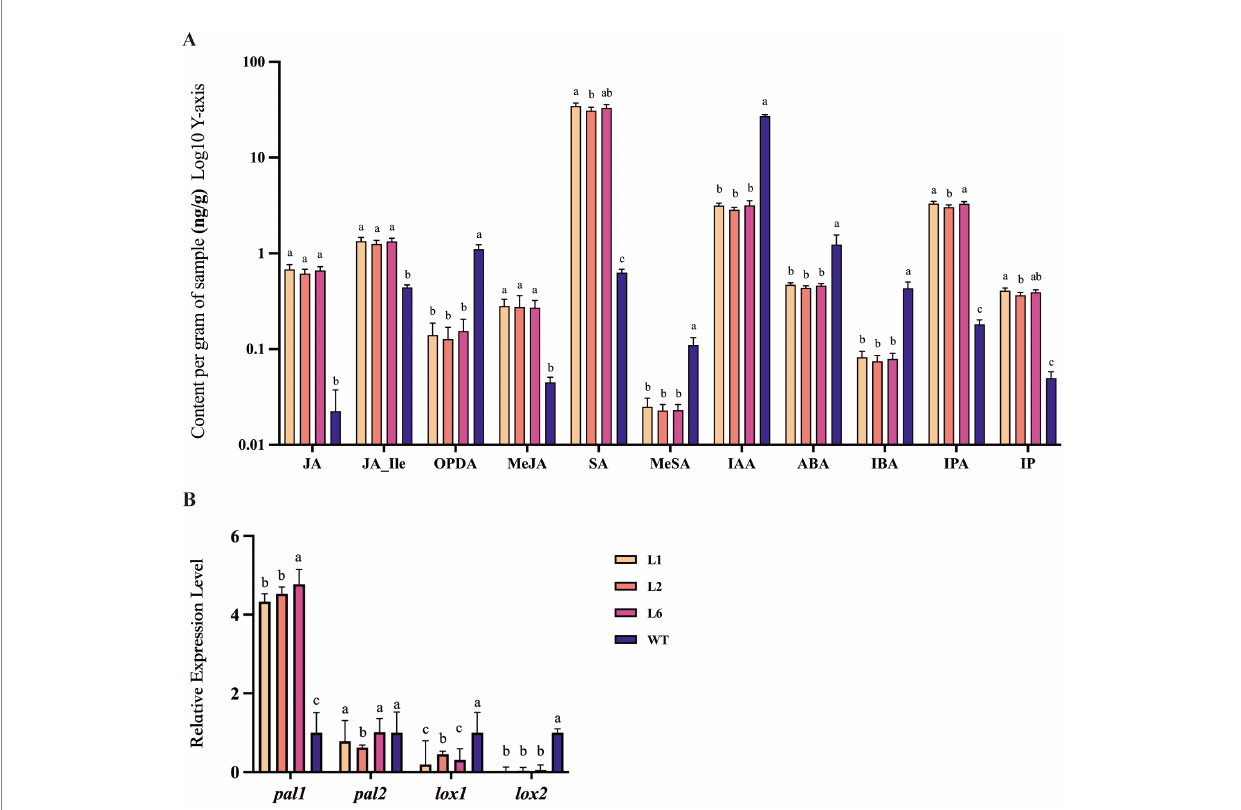
FIGURE 3 The changes of hormone levels in Polec2 overexpressing strains (L1, L2 and L6). (A) Change in different hormone levels (using a log scale), including the production of salicylic acid (SA), methyl salicylate (MeSA), jasmonic acid (JA), 12-oxo-phytodienoic acid (OPDA), jasmonic acid-isoleucine (JA-Ile), jasmonic acid methyl ester (MeJA), indole-3-acetic acid (IAA), 3-indole butyric acid (IBA), abscisic acid (ABA), in-dolepropionic acid (IPA), and isopentenyladenine (IP). (B) Expression analysis of genes in the SA- and JA-signaling pathways, including two phenylalanine ammonia-lyases pal1 and pal2 for SA biosynthesis and two Lipoxygenases lox1 and lox2 for JA biosynthesis. Letters indicate significant differences from the WT strain (p < 0.05, Waller-Duncan